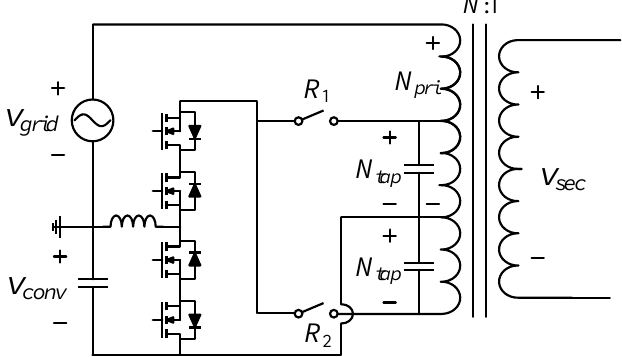
Figure 4. Circuit configuration of improved one stage active hybrid solid state transformer.